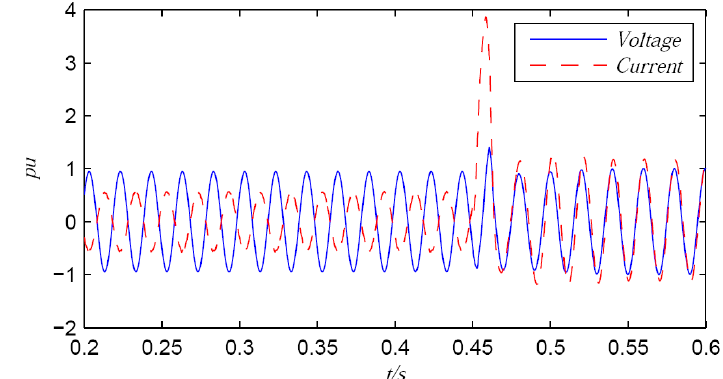
Figure 7. Single ‐ phase voltage and current output. Figure 7. Single-phase voltage and current output.